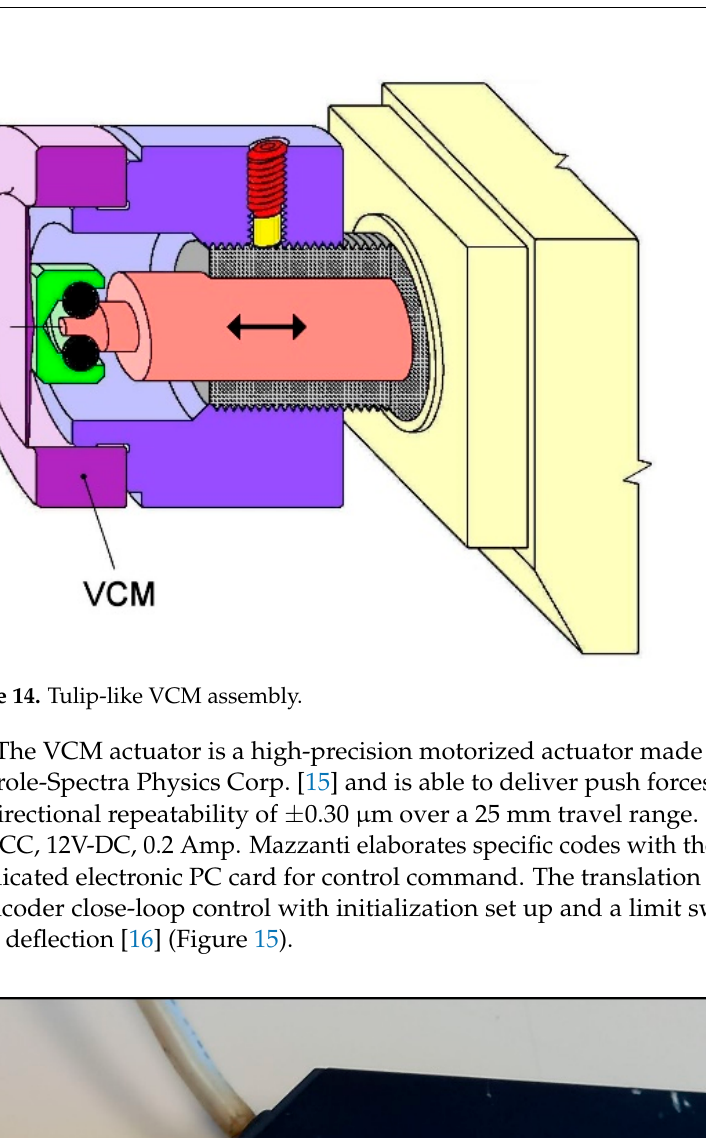
Figure 14. Tulip ‐ like VCM assembly.